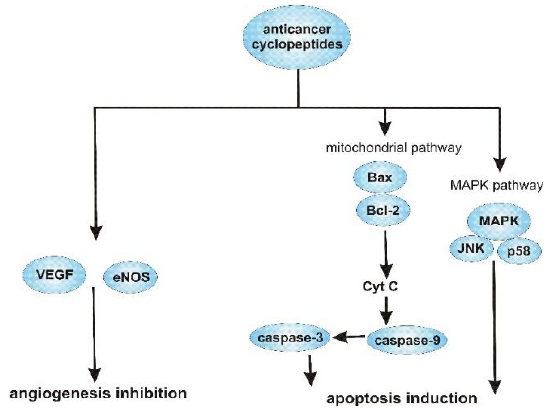
Figure 2. Molecular mechanisms of anticancer